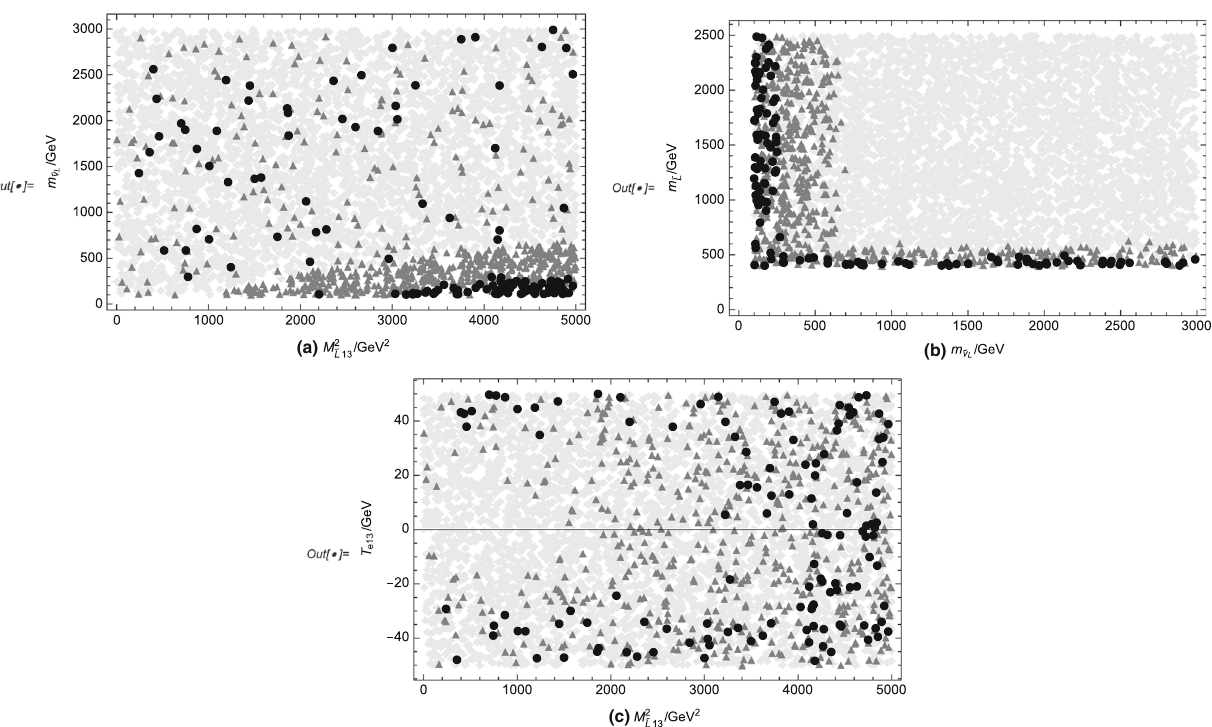
Fig. 11 For the scatter diagrams of the parameters below the experimental limit Br (τ → e γ) , different points represent the different ranges of Br (τ → e γ) . (cid:2) represent less than 1 . 0 × 10 − 10 . (cid:3) represent the range of 1 . 0 × 10 − 10 to 8 . 0 × 10 − 10 , and • represent the range of 8 . 0 × 10 − 10